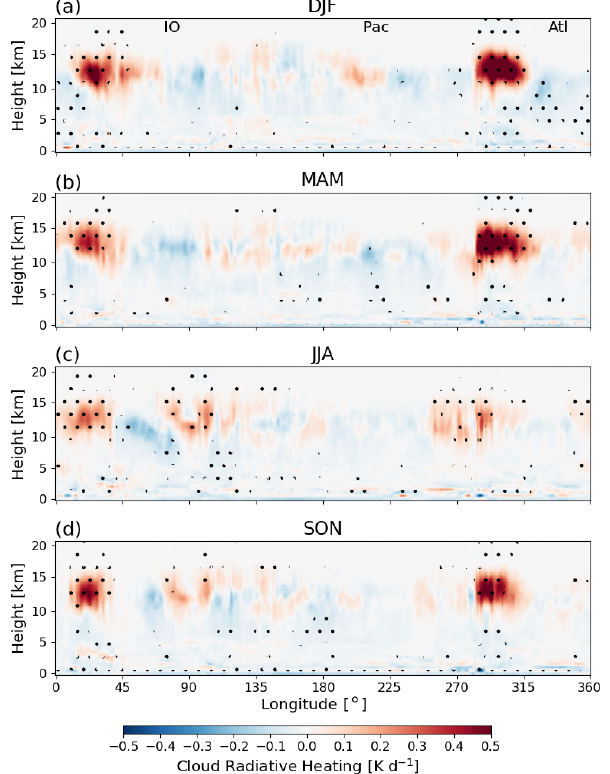
Figure 4. Cloud radiative heating difference between EC-Earth model version 3.3.1 and the PRIMAVERA standard resolution (EC- Earth3 minus EC-Earth3P). The differences where a Student t test has a 95% confidence based on monthly mean values are marked with black